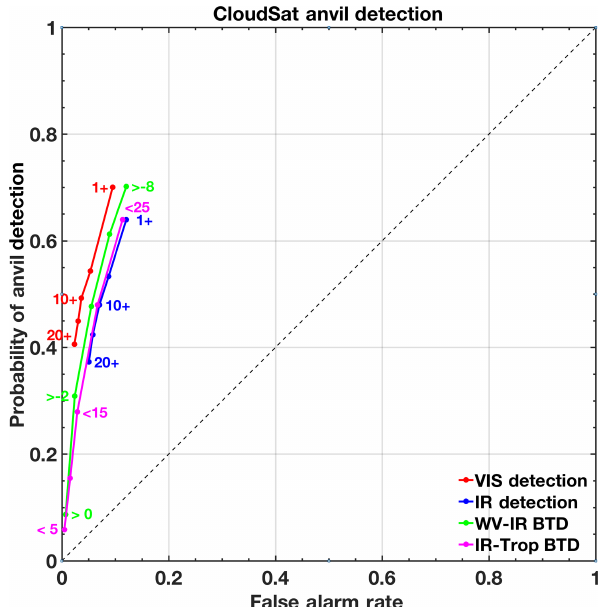
Figure 12. Receiver operating characteristic curves highlighting the rate of CloudSat anvil detection based on the VIS mask, the IR mask, the WV − IR BTD test, and the IR − Trop BTD test relative to the rate of false alarms. The VIS and IR masks are evaluated from ratings of 1 or greater up to ratings of 20 or greater, the WV − IR BTD test is evaluated from differences of − 8K or greater to 0K or greater, and the IR − Trop BTD test is evaluated from differences of 25K or less to 5K or